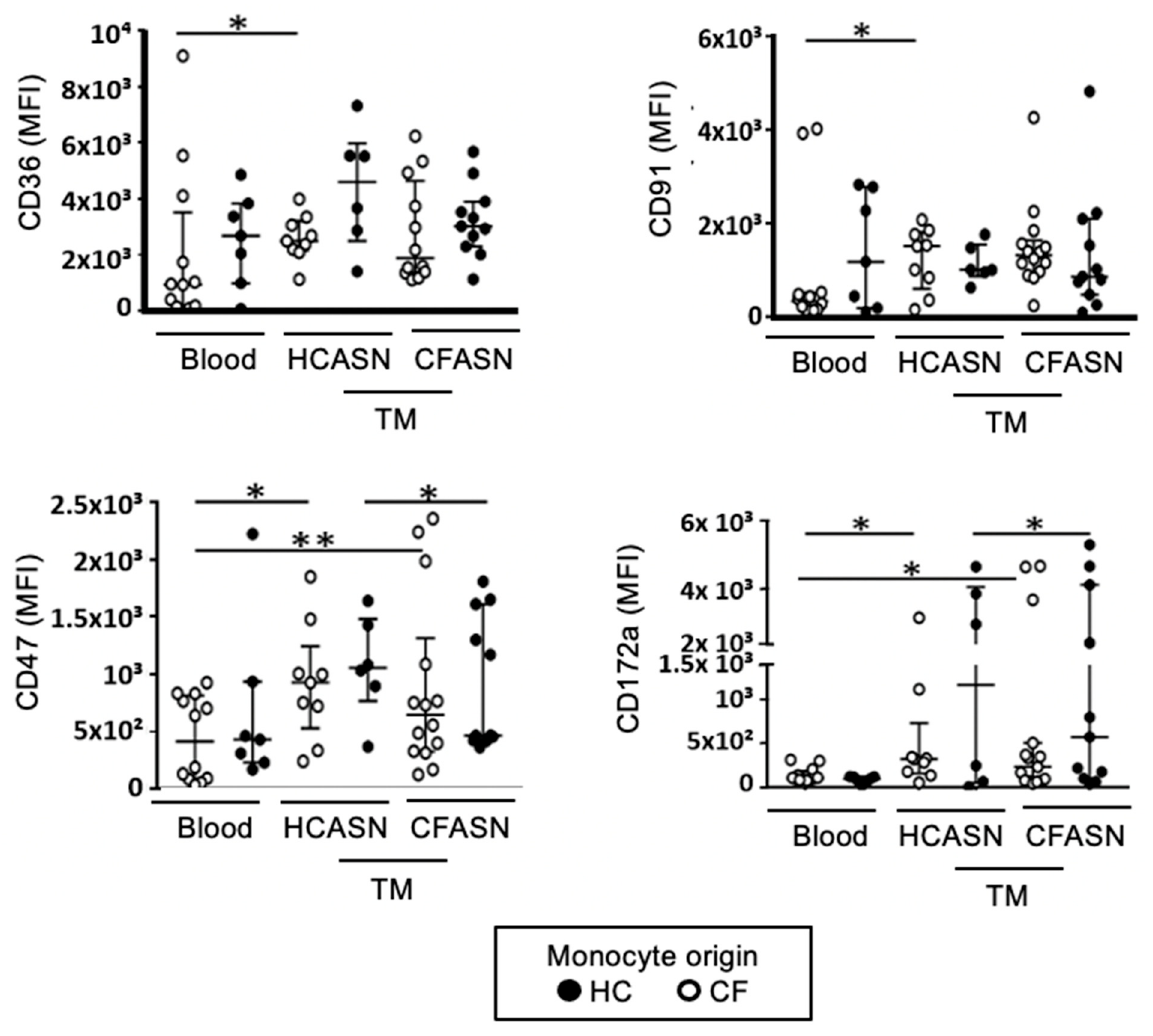
Figure 3. Expression of select scavenger receptors on transmigrated monocytes. Blood monocytes from HC or CF donors transmigrated into HCASN or CFASN were subjected to flow cytometric analysis to compare expression of scavenger receptors across subsets of transmigrated monocytes. Statistics: Mann-Whitney test for different monocytes (HC vs. CF) recruited to the same ASN (HC or CF) and Wilcoxon signed rank test for the same monocytes (HC or CF) recruited to different ASN (HC vs. CF). * and ** mark p < 0.05 and p < 0.01, respectively. n = 6–14 depending on condition. Non-significant differences not shown.